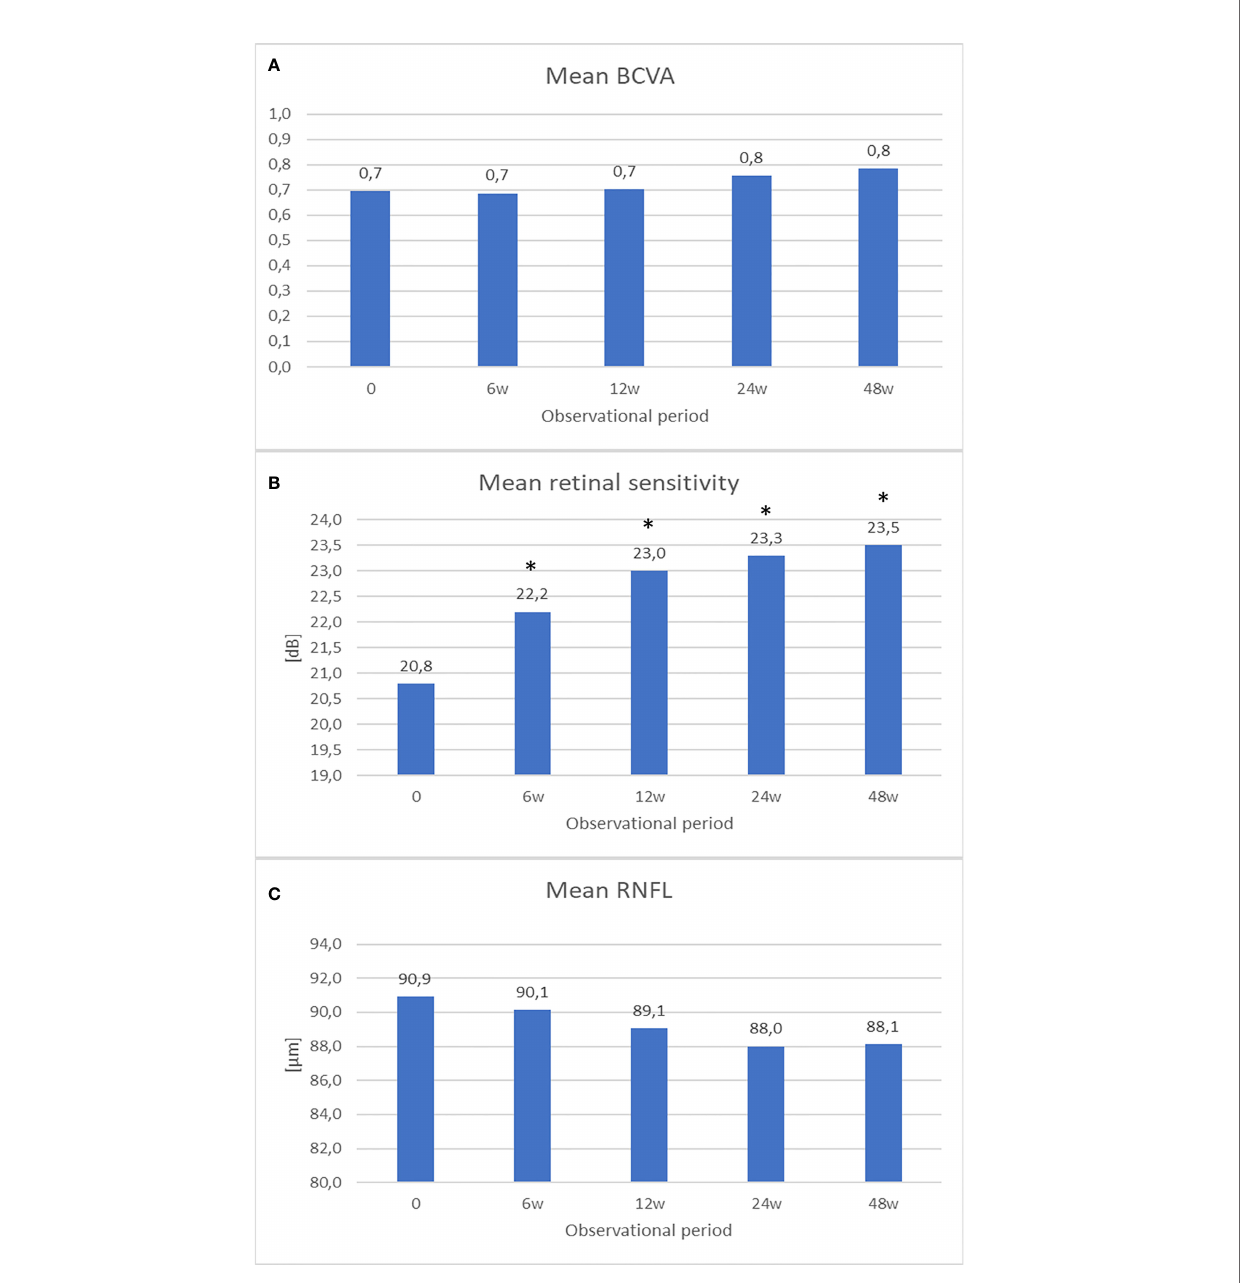
FIGURE 1 | The graphs show (A) mean best-corrected visual acuity (BCVA), (B) mean retinal sensitivity, (C) mean retinal nerve fi ber layer (RNFL) – at baseline and at 6, 12, 24, 48 weeks after treatment. * P < 0.05 vs. baseline